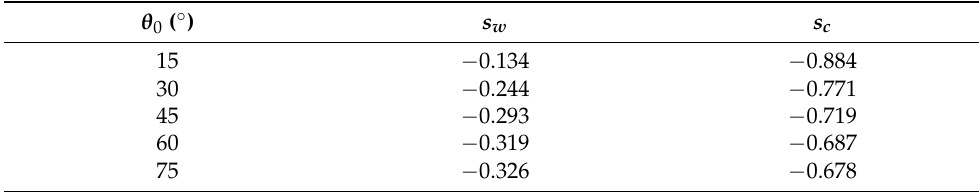
Table 2. Decay slopes of centreline velocity and concentration calculated at the last cycle of simulation for initial inclination angles